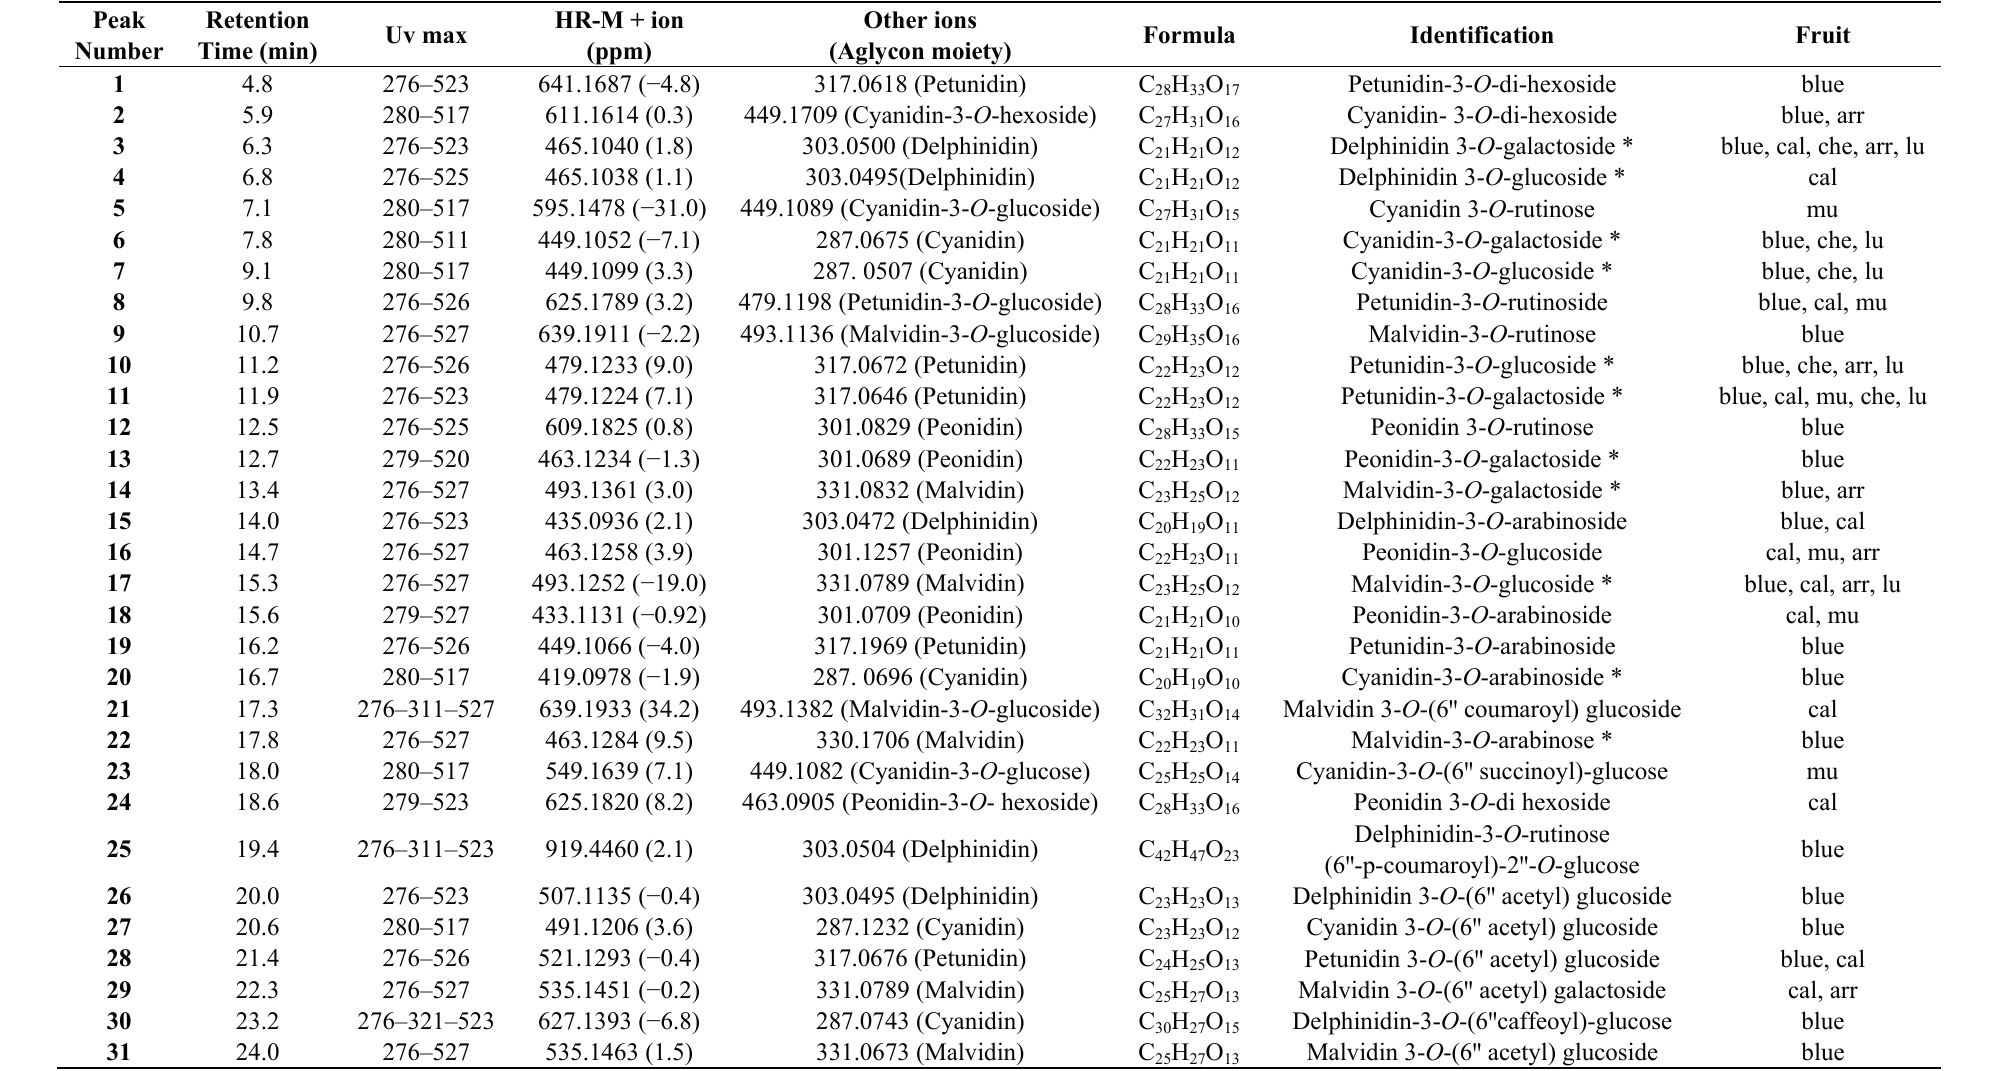
Table 1. Identification of phenolic compounds in chilean berries by LC-PDA-HR-ToF-ESI-MS